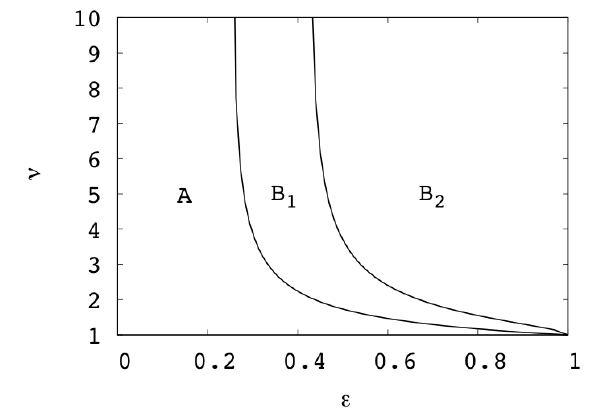
Figure 6 . Regions of ( (cid:15); (cid:23) ) with di(cid:11)erent temperature behaviour of subregion C 2 : 0 with temperature at constant J in regions A and B 2 , while it increases in region B 1